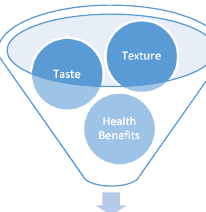
Figure 2. Relationships between attributes.